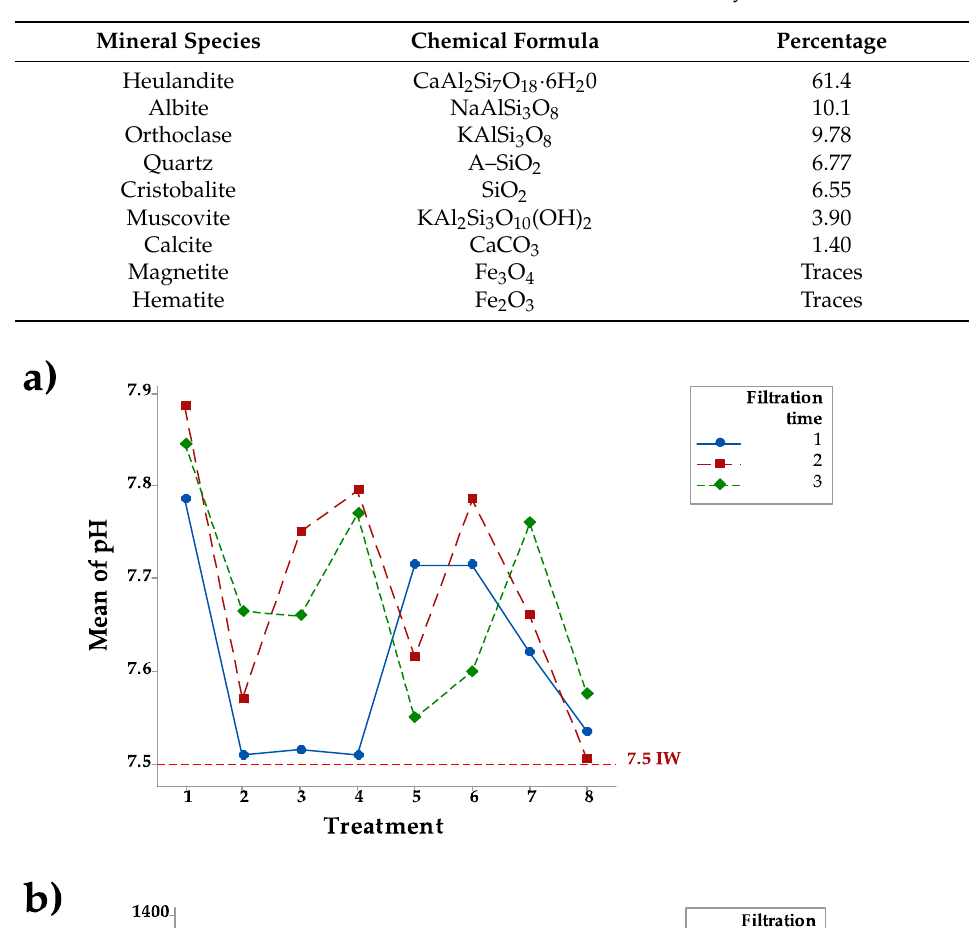
Table 2. Chemical characterization of the natural zeolite used in the study.